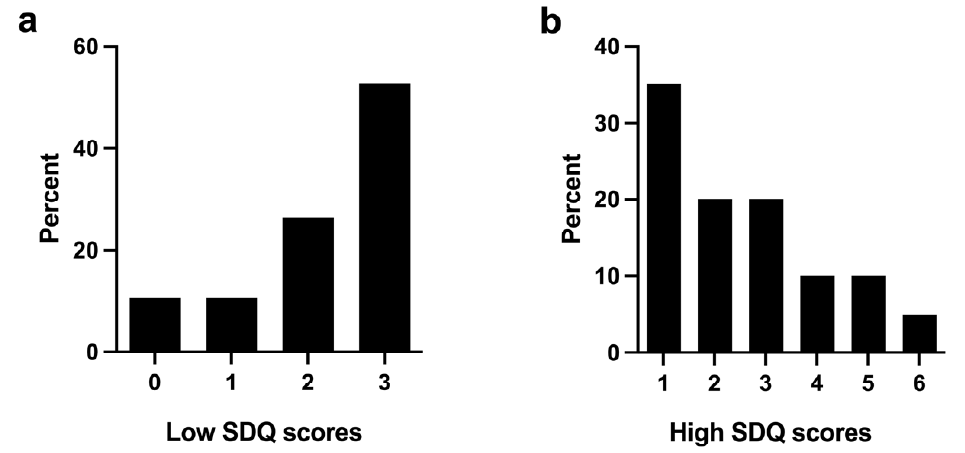
Figure 1. Fraction of SDQ scores among the Walnuts participants among ( a ) low SDQ scores (values of 0–3) and ( b ) high SDQ scores (values of 18–25). Table 1. Demographic information and the range of the SDQ score, the execution age of SDQ and blood tests, and the sex distribution of study subjects.